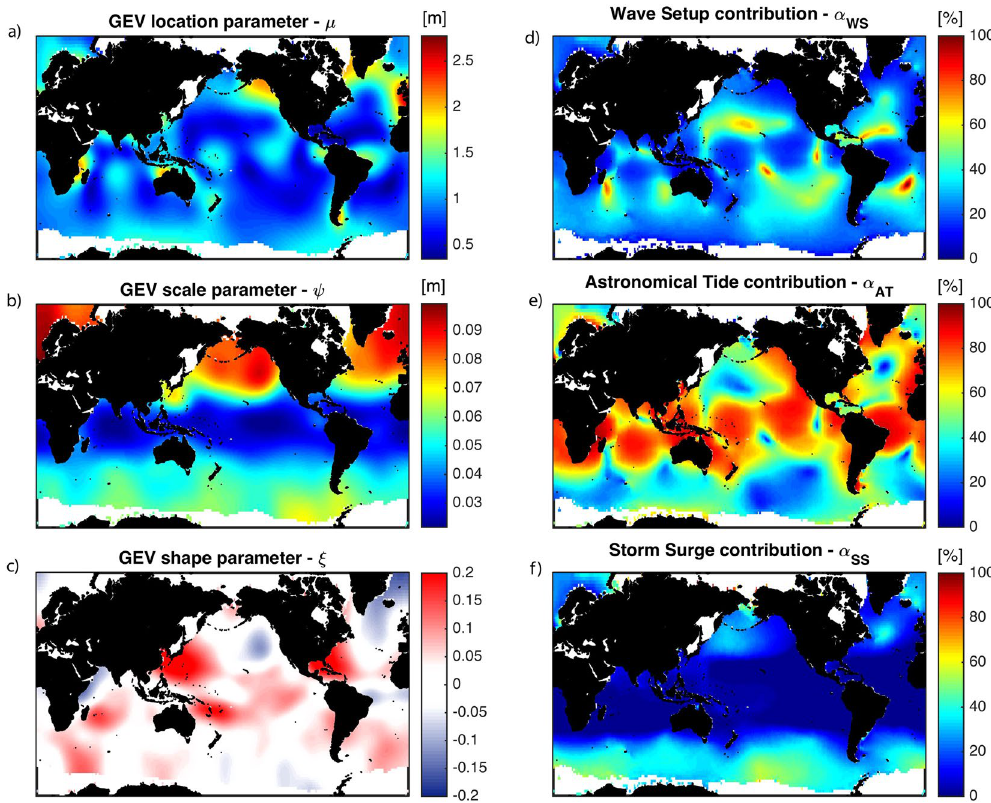
Figure 1. Classification parameters. Global variability of the six classification parameters ( µ , ψ , ξ , α AT, α SS, α WS), where µ , ψ , and ξ are the location, scale parameter, and shape parameters of the fitted GEV distribution of TWL, respectively, and α AT, α SS, and α WS are the average relative contribution of the astronomical tide, storm surge, and wave setup to the annual maxima of TWL, respectively. All these maps were created with Matlab 2014b